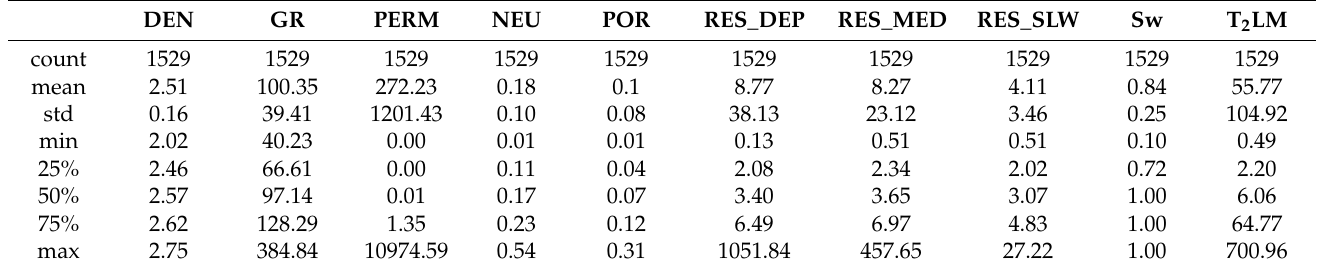
Table 3. Summary statistics of the data used in the machine learning